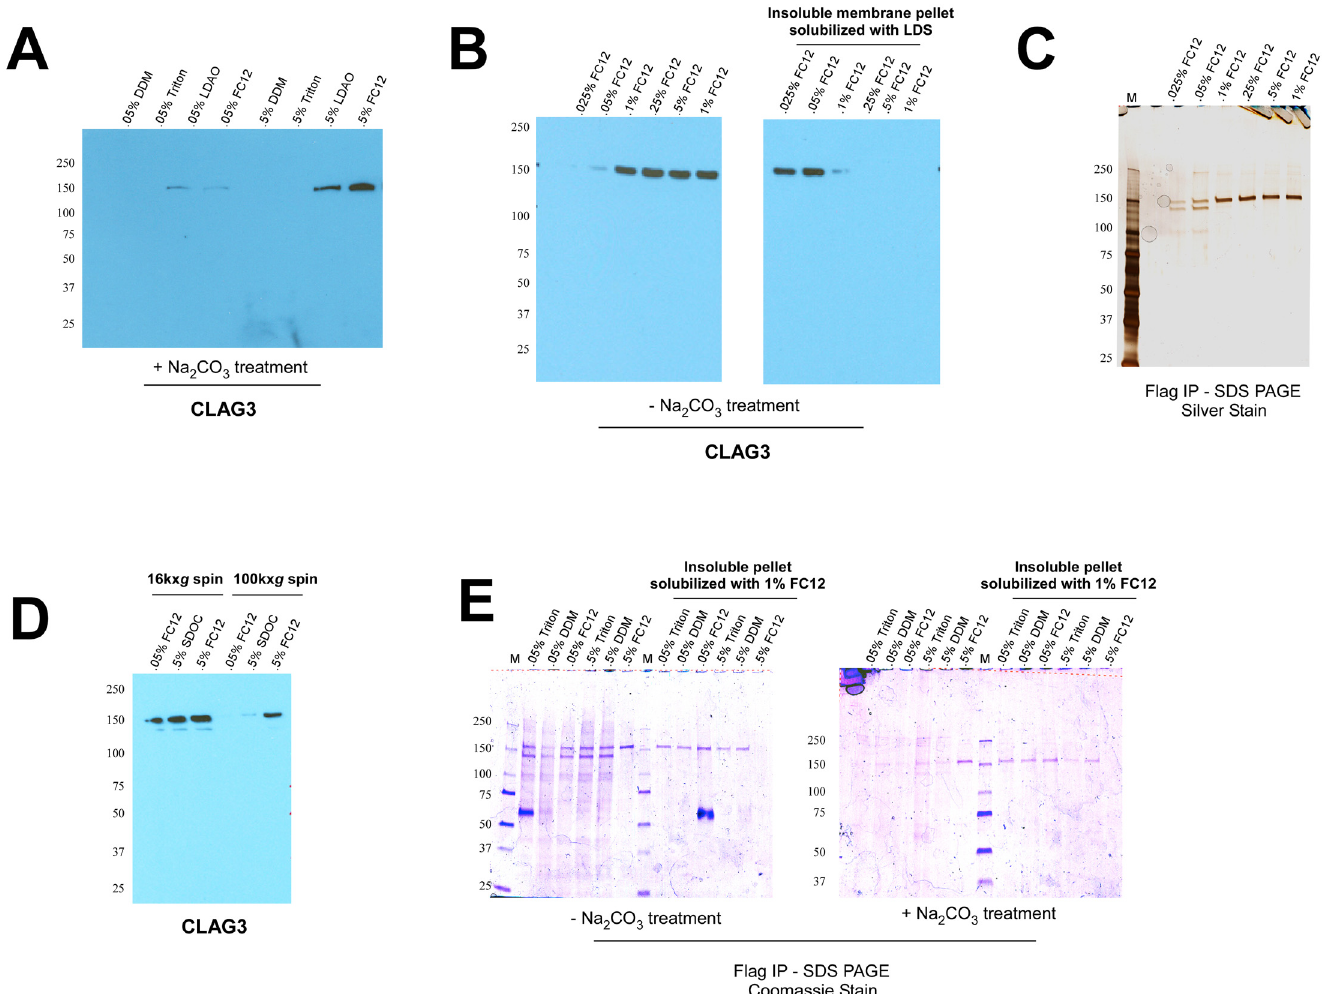
Fig 1. Solubilization and immunoprecipitation of membrane-associated CLAG3. (A) Western blot analysis shows that the zwitterionic detergents, lauryldimethyl amine oxide (LDAO) and fos-choline 12 (FC12), are able to solubilize integral CLAG3 at 0.5% (w/v) from sodium carbonate pH 11 (Na 2 CO 3 ) treated trophozoite-infected erythrocyte membranes. (B) FC12 solubilizes total CLAG3 from (non-carbonate treated) membranes at concentrations 0.1% or above, leaving almost nothing behind in the insoluble membrane pellet. (LDS: lithium dodecyl sulfate). (C) Immunoprecipitation (IP) of CLAG3 from a previously described FLAG-tagged CLAG3 parasite (HB3 3REC ) results in the appearance of the expected 160kDa CLAG3 band at FC12 concentrations (cid:1) 0.1%, and two additional faint bands (150kDa and 100kDa) at FC12 concentrations (cid:3) 0.05% [8]. (D) Substantially more CLAG3 remains in the detergent-soluble supernatant following a 16,000x g spin to pellet insoluble material as compared to a traditional 100,000x g spin for all detergents tested (SDOC: sodium deoxycholate). (E) IP experiments were repeated incorporating the slower 16,000x g spin. All detergents tested (with the exception of 0.5% FC12) give rise to the aforementioned three bands in non-carbonate (-Na 2 CO 3 ) treated membranes, but fail to do so in membranes treated with sodium carbonate (+Na 2 CO 3 ). As evidenced by the right half of each gel, the only detergent able to fully solubilize CLAG3 from membranes (and leave nothing behind in the insoluble pellet) is 0.5% FC12. The prominent 60kDa band corresponds to heavy chain